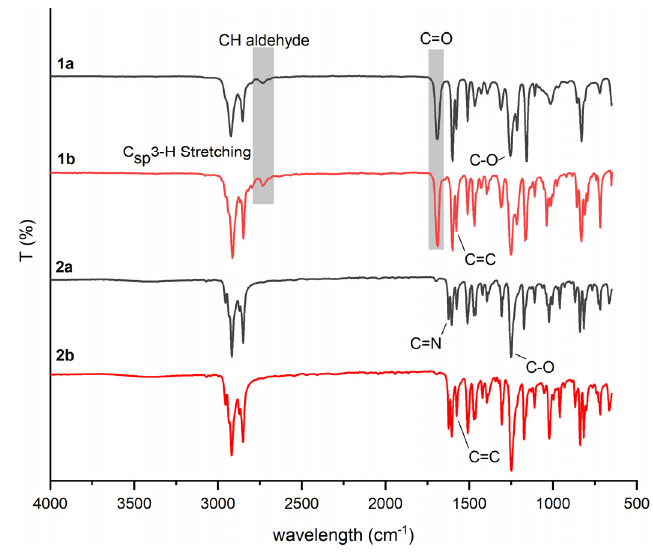
Figure 1. Overlay of FT-IR spectra of compounds 1a – b and 2a – b .